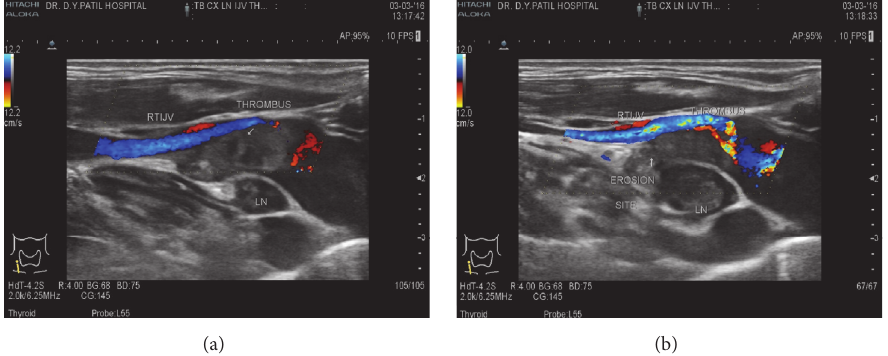
Figure 3: Color Doppler study showing IJV thrombus seen as filling